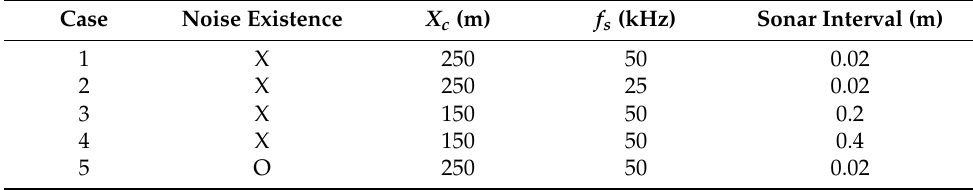
Table 1. Simulation Case for Single Sensor.